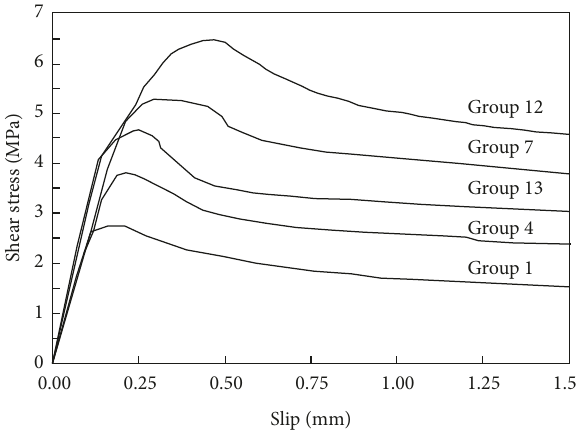
Figure 9: Typical shear-slip curves from Papanicolaou and Tri- antafillou [17].